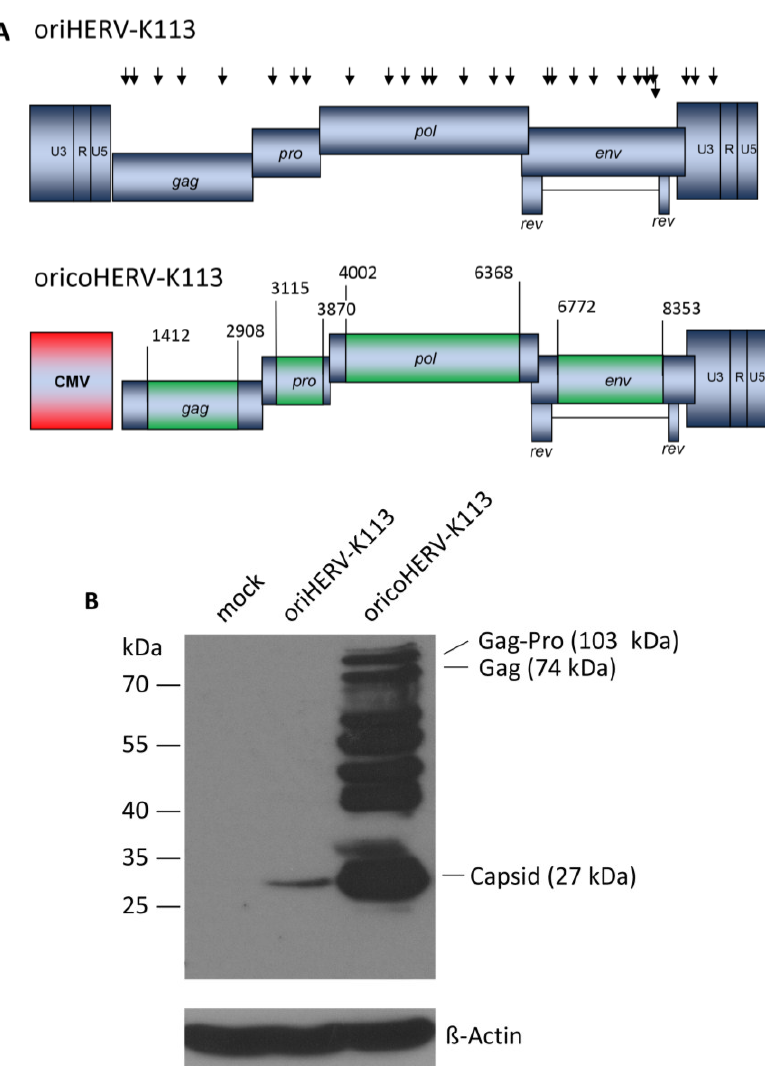
Figure 1. Genomic organization and expression of the reconstituted human endogenous retrovirus (HERV-K) human MMTV-like-2 HERV-K(HML-2) sequence “oriHERV-K113” and the partial codon-optimized variant with CMV promoter “oricoHERV-K113”. ( A ) For reconstitution of the potential infectious progenitor sequence of the HERV-K(HML-2) element, 25 non-synonymous putative post-insertional mutations (indicated by black arrows, lower arrow refers to rec reading frame) in the HERV-K113 genome sequence (AY037928) were reverted to generate oriHERV-K113. In oricoHERV-K113, parts of the oriHERV-K113 genome were codon-optimized (boxed in green) to achieve maximal expression in mammalian cells, leaving potential regulatory sequences or overlapping regions in the genome unaltered. The 5'LTR region was replaced by a CMV promoter (red). Numbers given for start and end of codon-optimized regions refer to genbank sequence AY037928. ( B ) Western blot of intracellular Gag proteins, processing fragments and degradation intermediates after transfection of the molecular clones in HEK 239T cells using a Gag (CA)-protein-specific antiserum for detection. Bands presumably representing the Gag-Pro, Gag and CA proteins are indicated. Stripping and re-probing of the